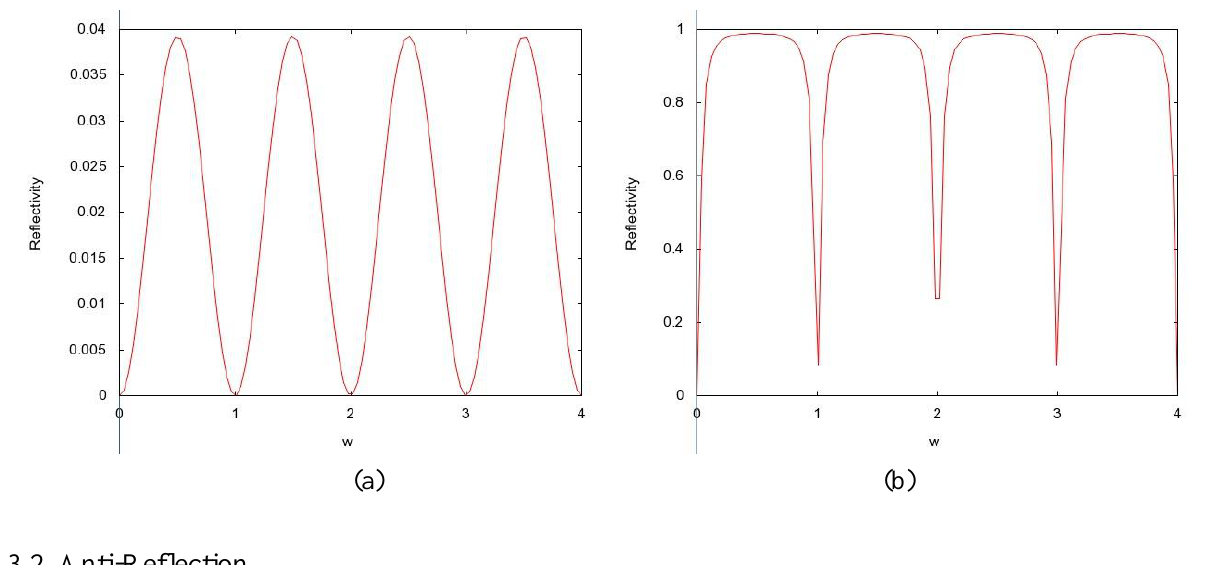
= − R = 0.9 (b). The period is ω 0 1